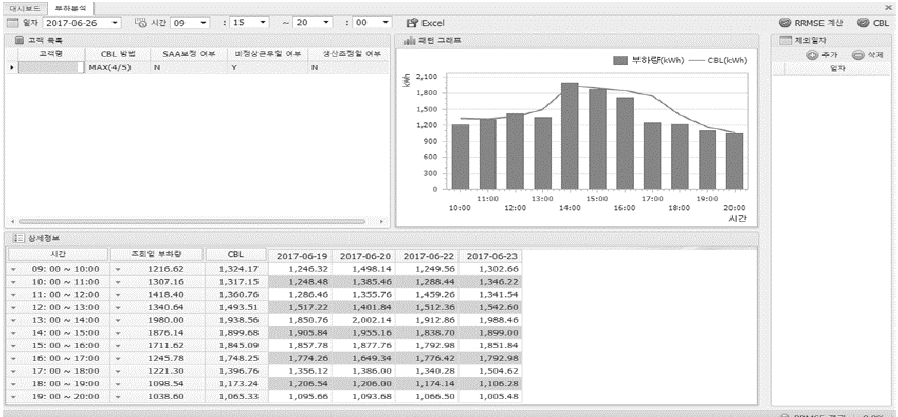
Figure 7. Provincial government building CBL calculation. Appl. Sci. 2020 , 10 , x FOR PEER REVIEW